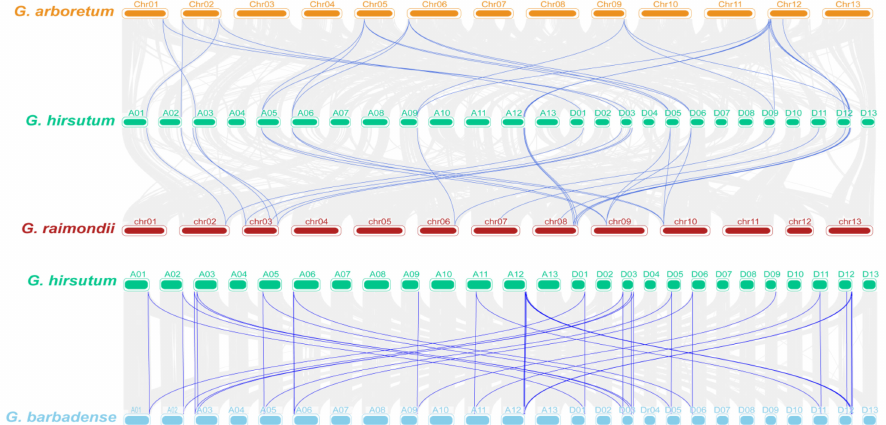
Figure 4. Collinearity analysis of the TPP family members in cotton. From top to bottom, the collinear relationships between G. arboreum and G. hirsutum , between G. barbadense and G. raimondii , and between G. hirsutum and G. barbadense are shown. The grey lines in the back- ground show the collinearity of the entire genome, and the blue lines indicate the collinearity of the TPP